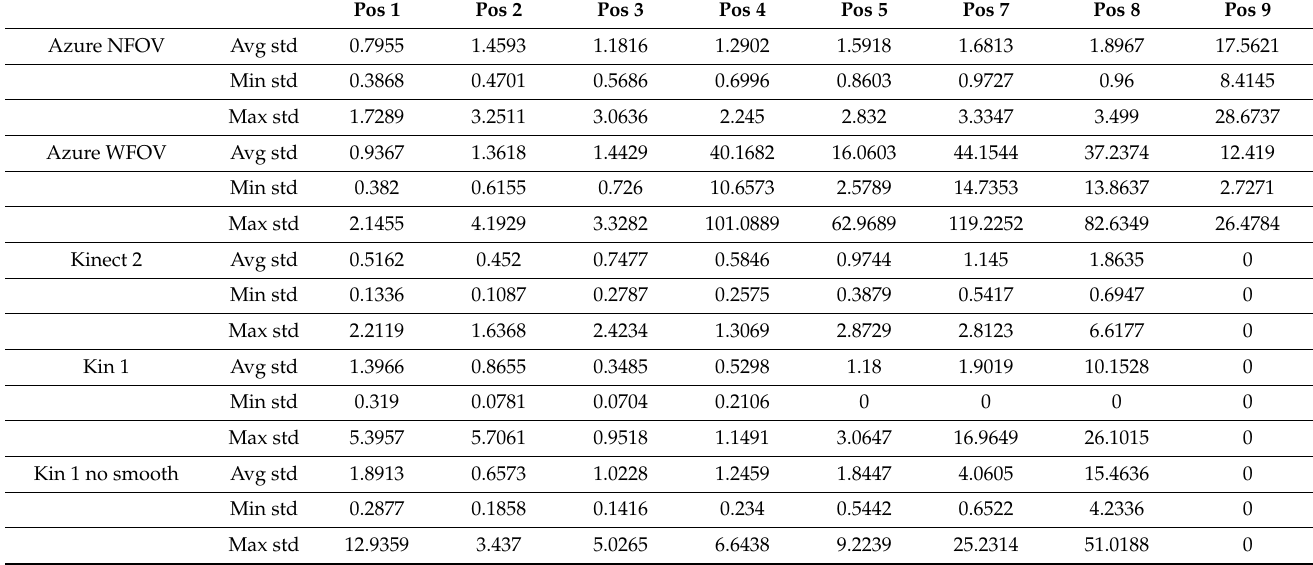
Table 4. Key noise data for all positions and